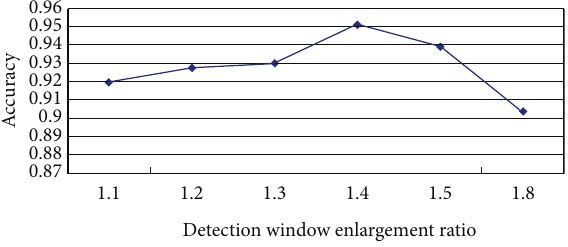
Figure 21: The influence of the sliding window resizing ratio 𝛾 on detection